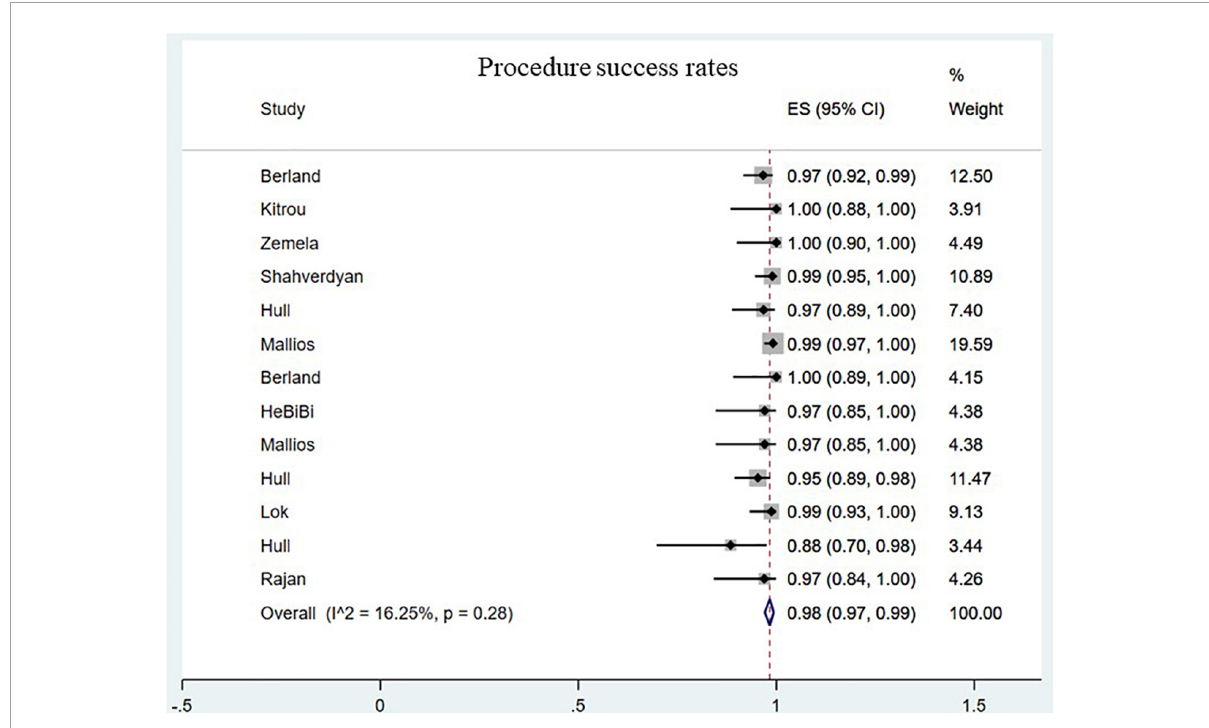
FIGURE2 Pooled procedure success rates. CI, confidence interval; ES, effect size.